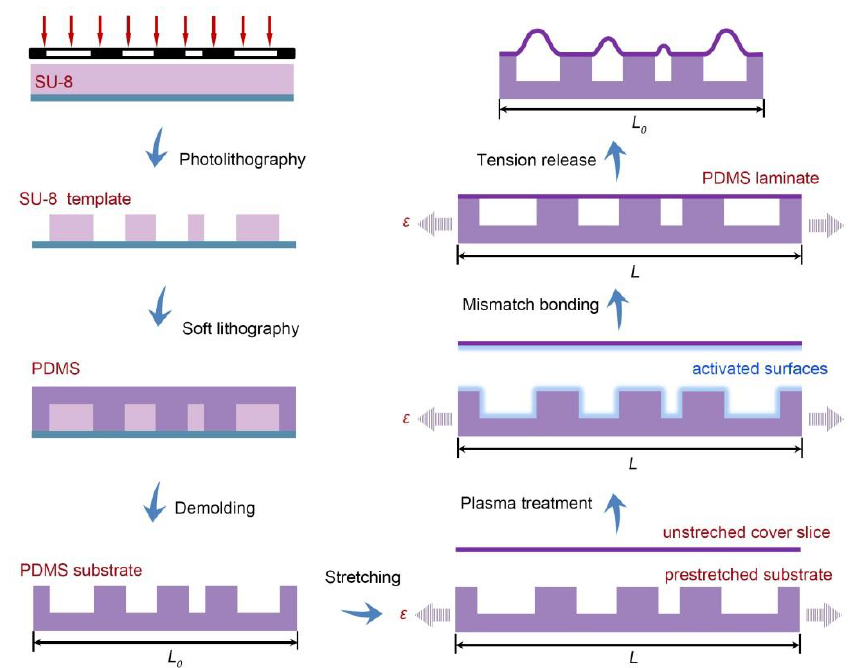
Figure 1. Schematic illustration of the mismatch bonding process for the fabrication of pneumatically actuated surface.